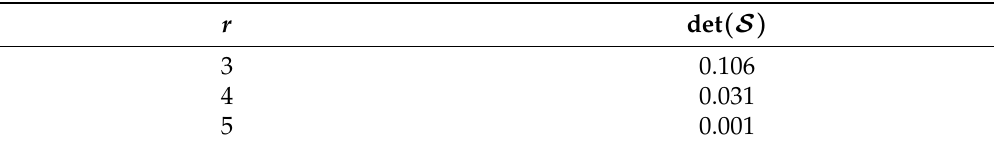
Table 1. Number of compounds r in the decomposition and respective minimal memory effect, det ( S ) . The decomposition with the smallest minimal memory effect is the one with r = 3. The minimal memory effect for r = 4 and r = 5 is orders of magnitude greater.